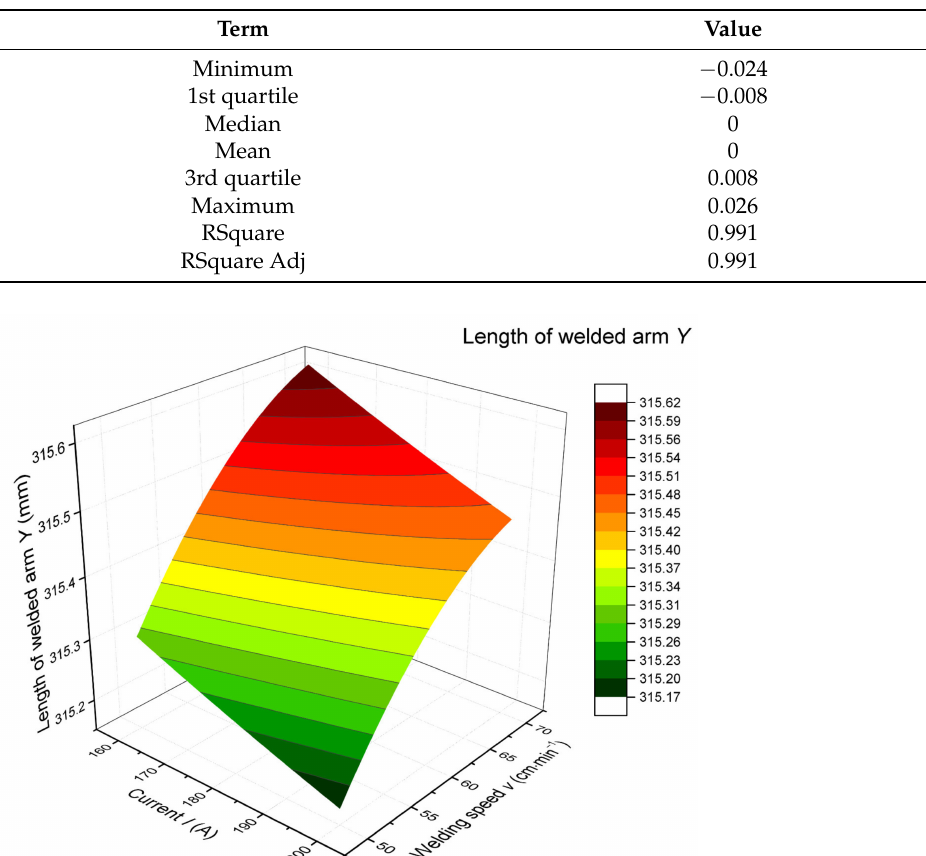
Table 13. Summary of residuals.